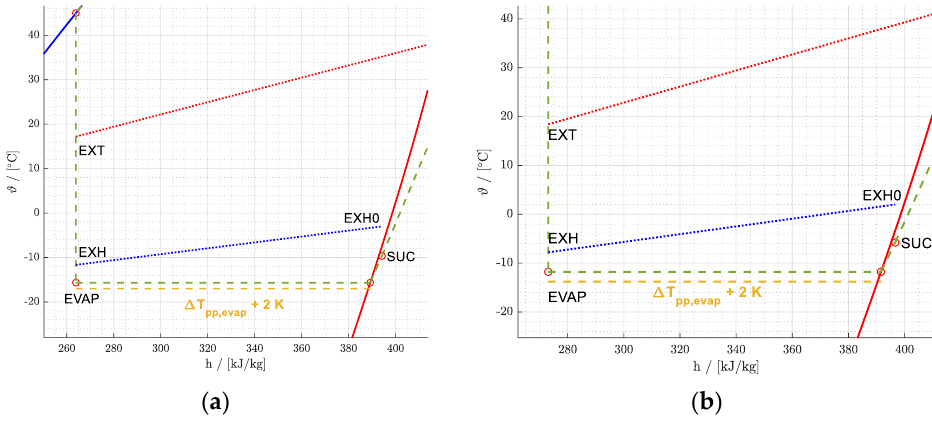
Figure 15. Influence of inflow characteristics and evaporator geometry on the refrigerant cycle for inlet air temperature of ( a ) − 3 °C and ( b ) 2 °C, with a homogeneous (green dash line) and non-homogeneous (yellow dash line) combination of airflow and evaporator geometry with 350 m 3 /h.